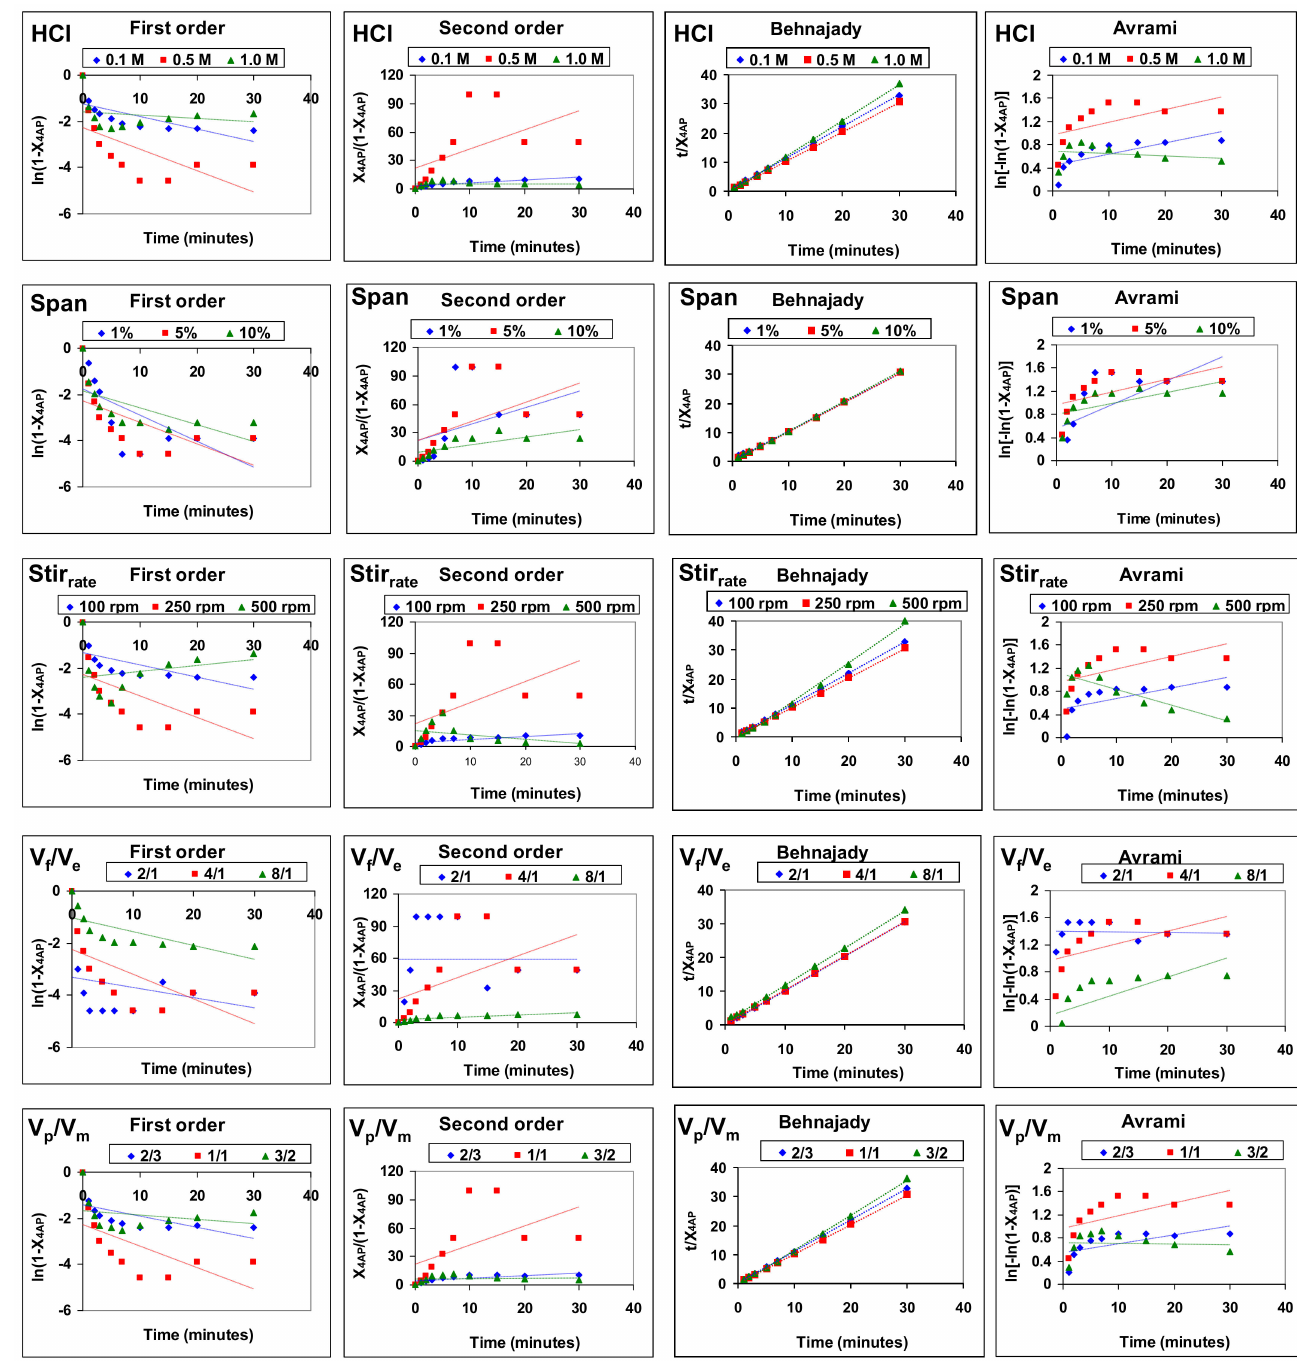
Figure 3. Fitting of the results of 4AP removal by emulsion liquid membranes using acid type 1 facilitation to the four kinetic models studied under the different experimental